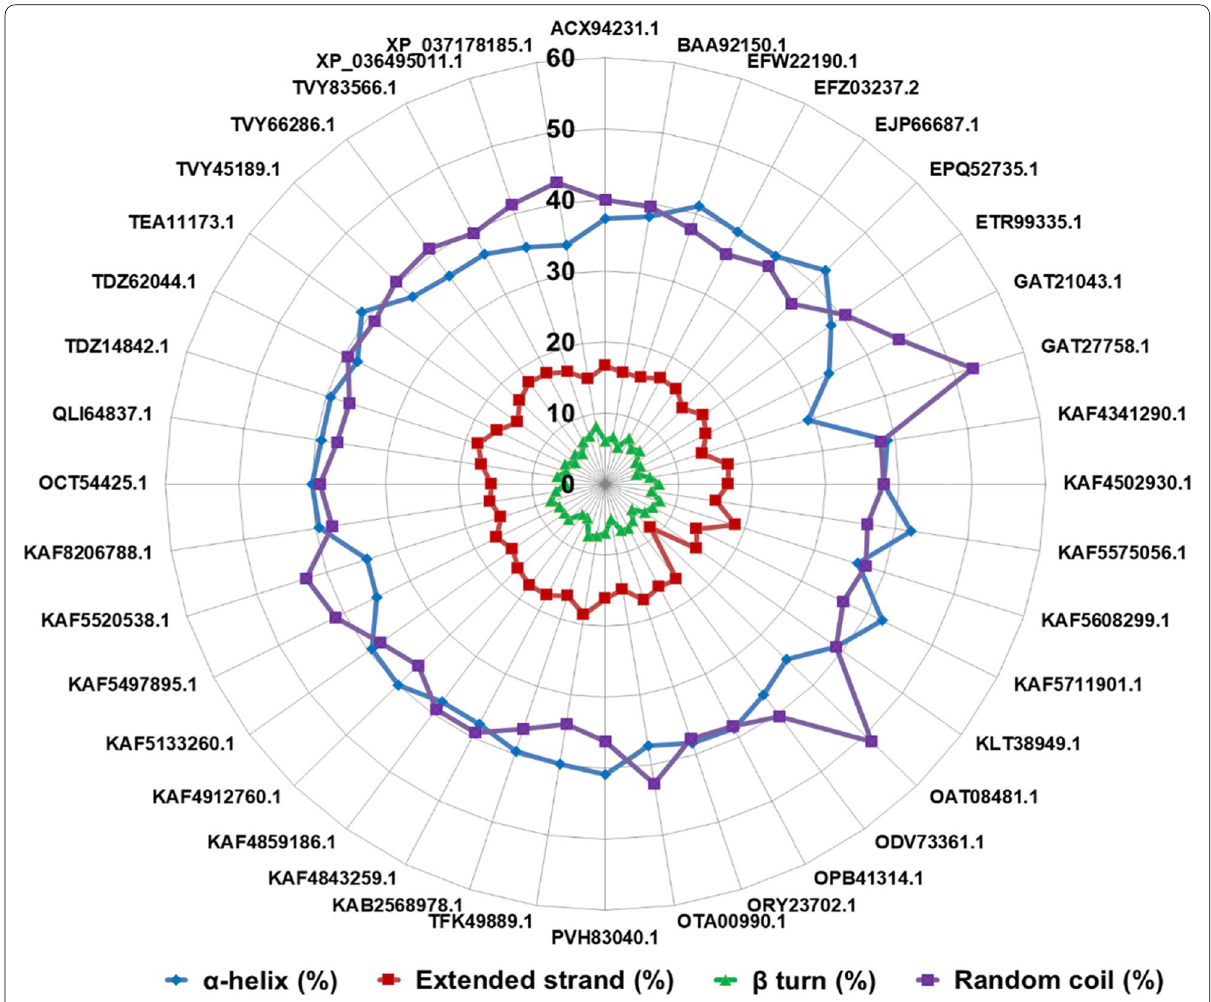
Fig. 3 Comparison of predicted secondary structural conformations among 40 fungal ACC